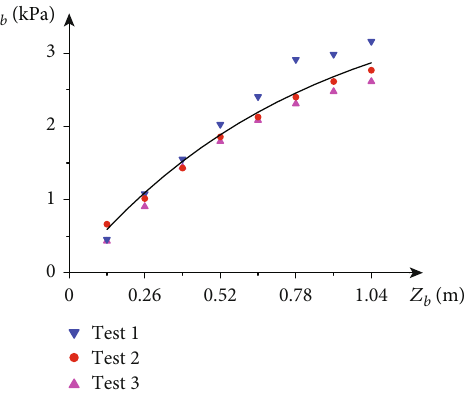
with the depth from the free surface of b